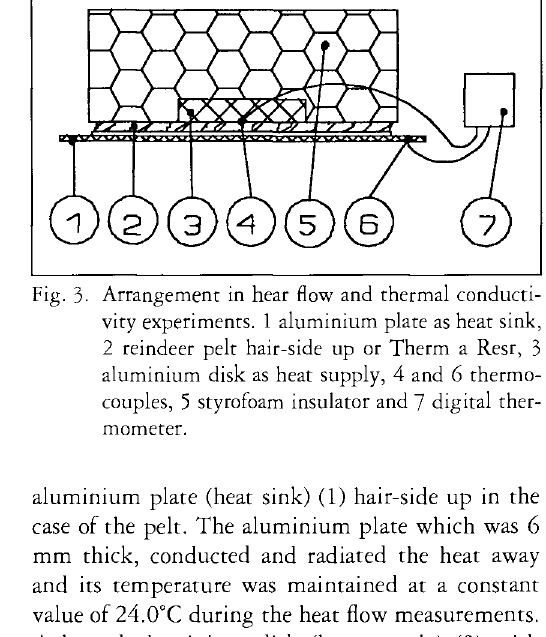
Fig. 5. Thermal conductivity, L, versus temperature dif ference,